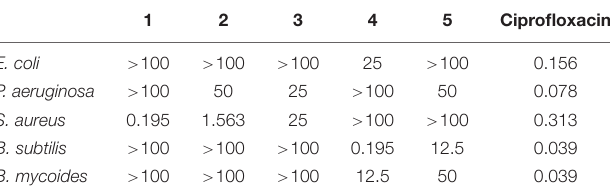
TABLE 4 | Antibacterial activities of 1 – 5 (MIC, µ g/ml).